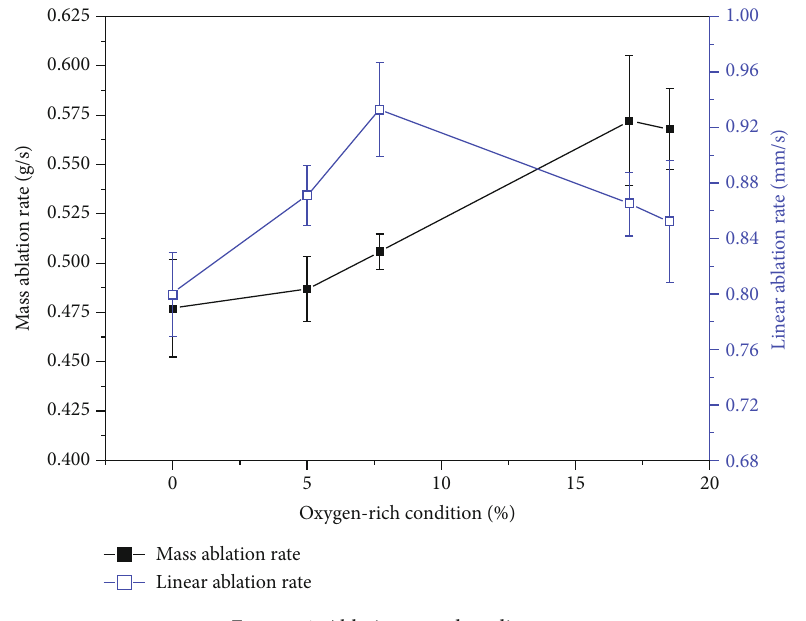
Figure 4: Ablation rate data diagram.